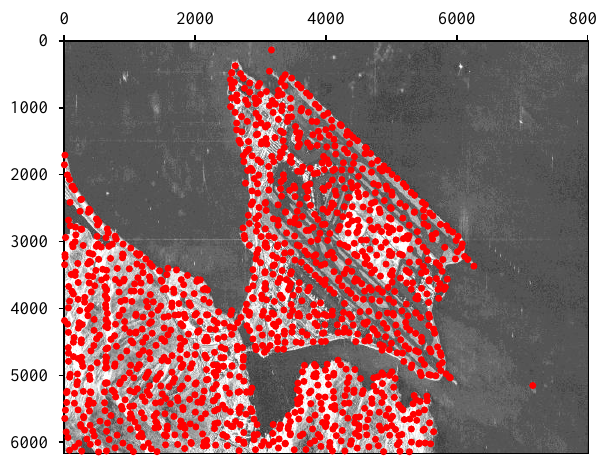
Figure 6. Distribution of the detected registration points by the proposed method.